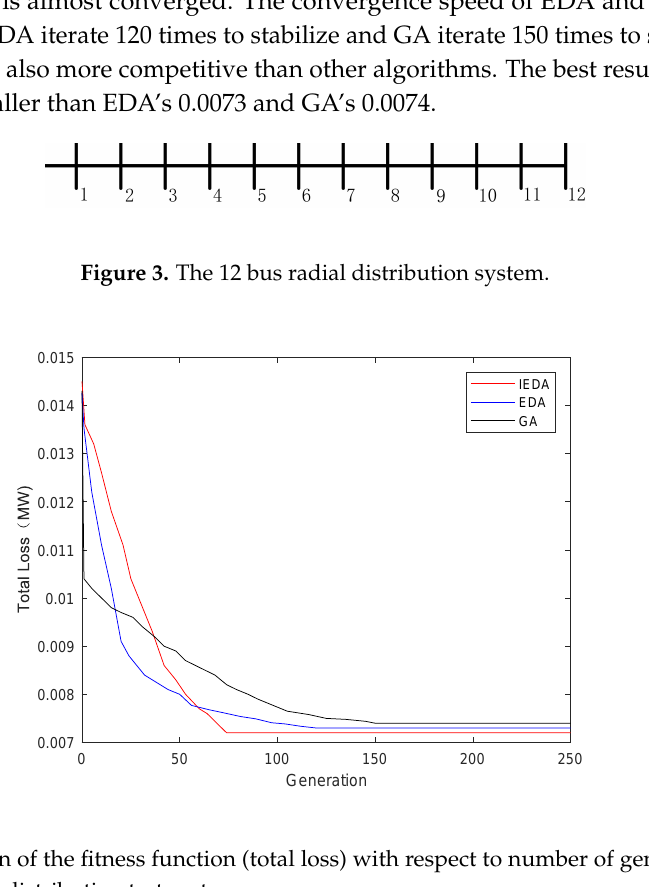
Figure 4. Evolution of the fitness function (total loss) with respect to number of generations for bus No. 9 in the 12 bus distribution test